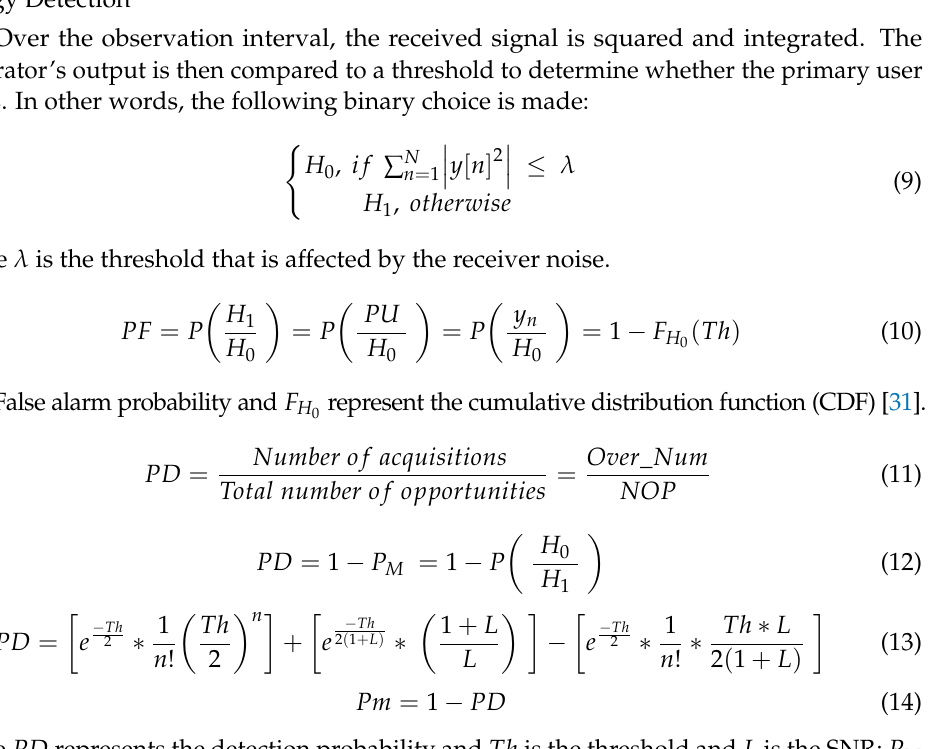
Figure 3. The window of opportunity for CR transmission.